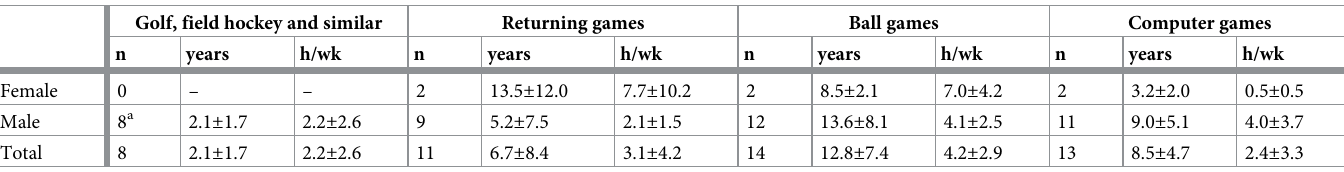
Table 2. Experience in selective sports and computer games (mean ± SD). Golf, field hockey and similar